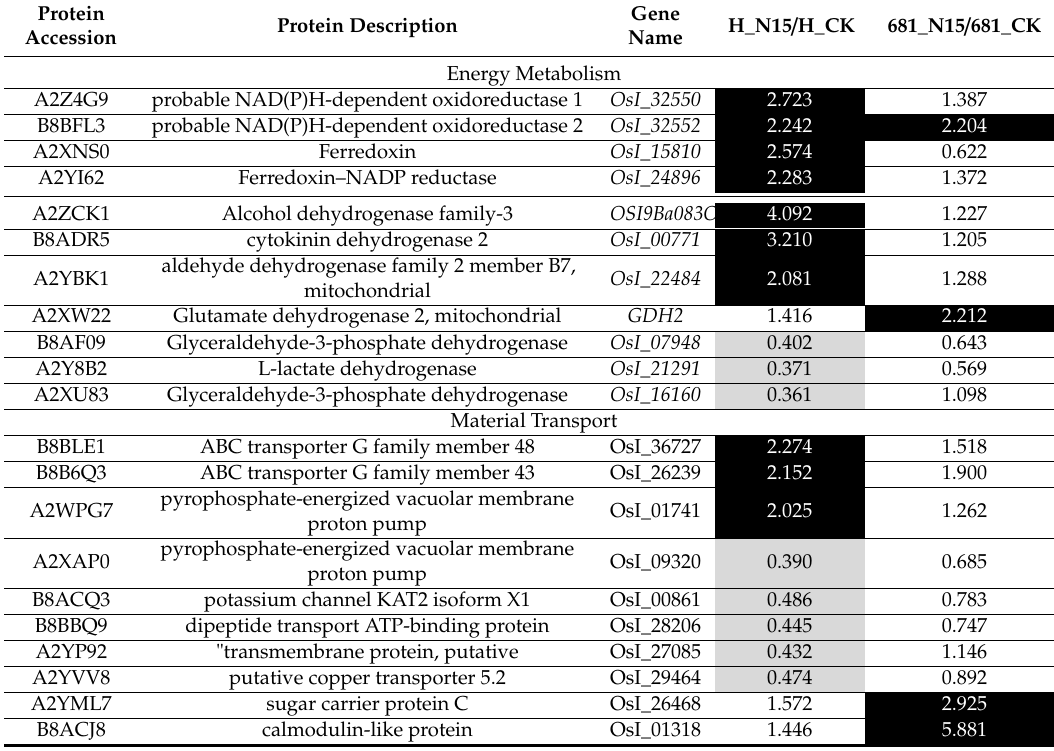
Table 4. The di ff erentially expressed proteins involved in energy metabolism and material transport in the comparisons of H_N15 vs. H_CK, and 681_N15 vs.